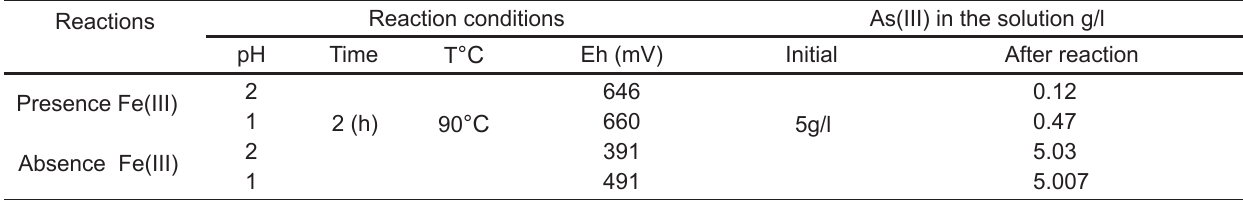
Table 1. Effect of Fe(III) on oxidation of As(III) Reactions Reaction